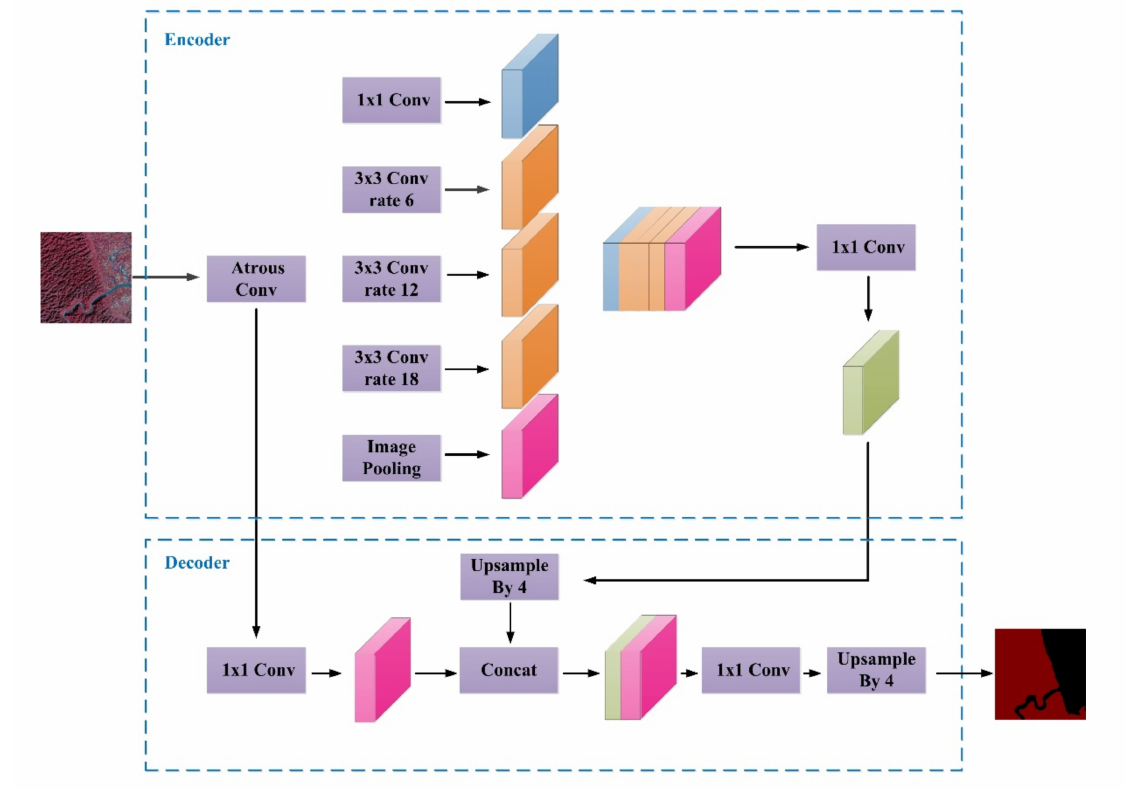
Figure 6. Network structure of the DeepLab V3+ model used in this